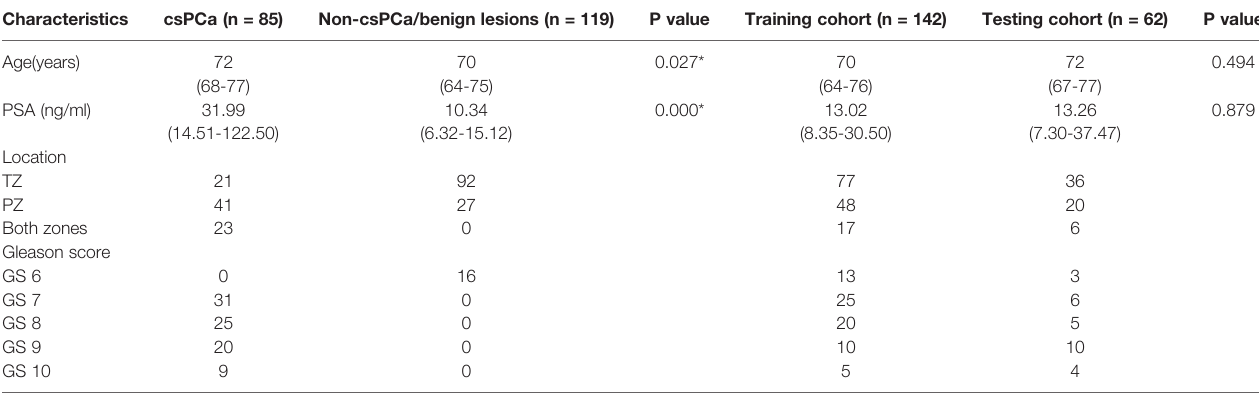
TABLE 2 | Patient